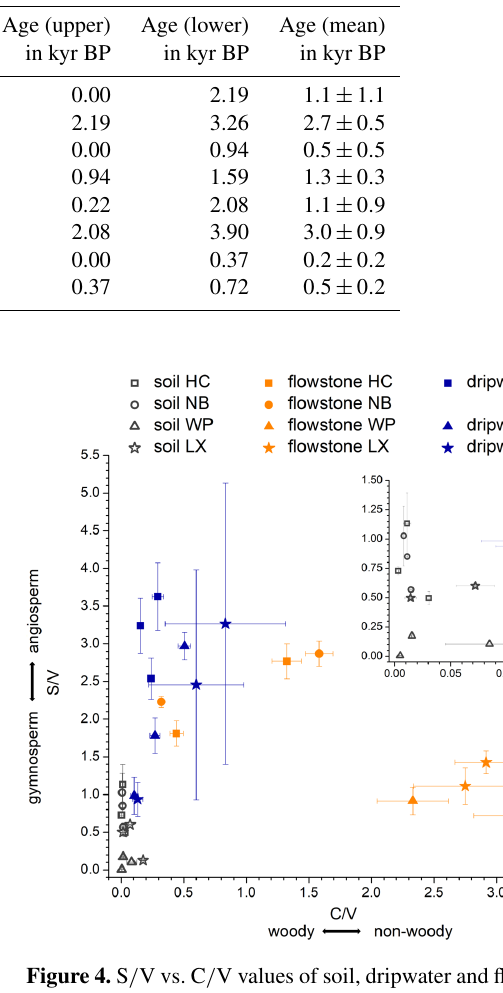
Table 1. Distance from the top (DFT) of upper and lower edges of the flowstone sample cubes (DFT (upper) and (DFT (lower)), ages calculated from the age model for upper and lower edges (age (upper) and (age (lower)), and calculated mean sample ages for the flowstone samples (age (mean)).